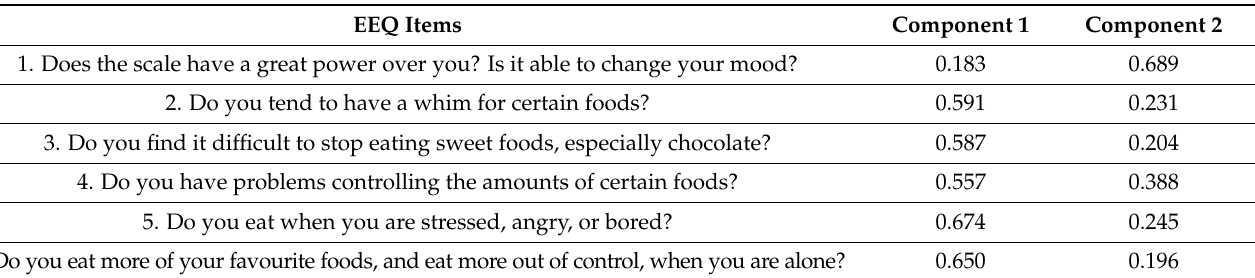
Table 4. Exploratory factor analysis of the EEQ ( N = 1282) ( p <